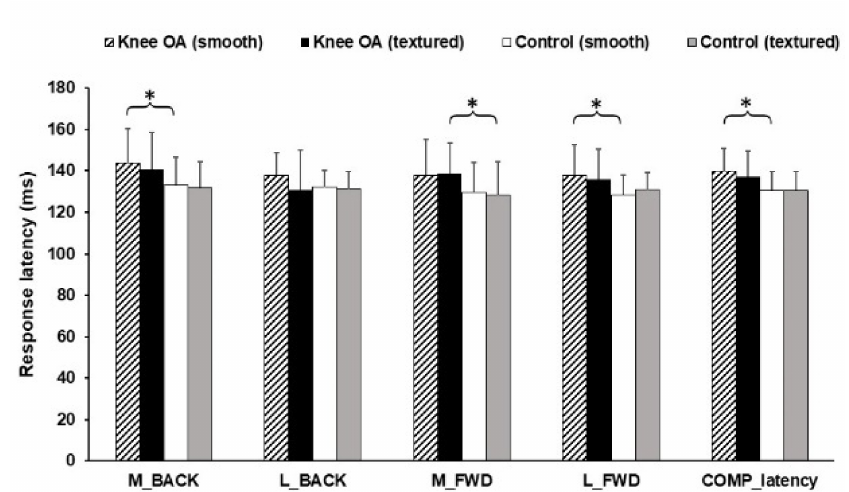
Figure 7. Results of latencies. * Statistically significant mean difference ( p <